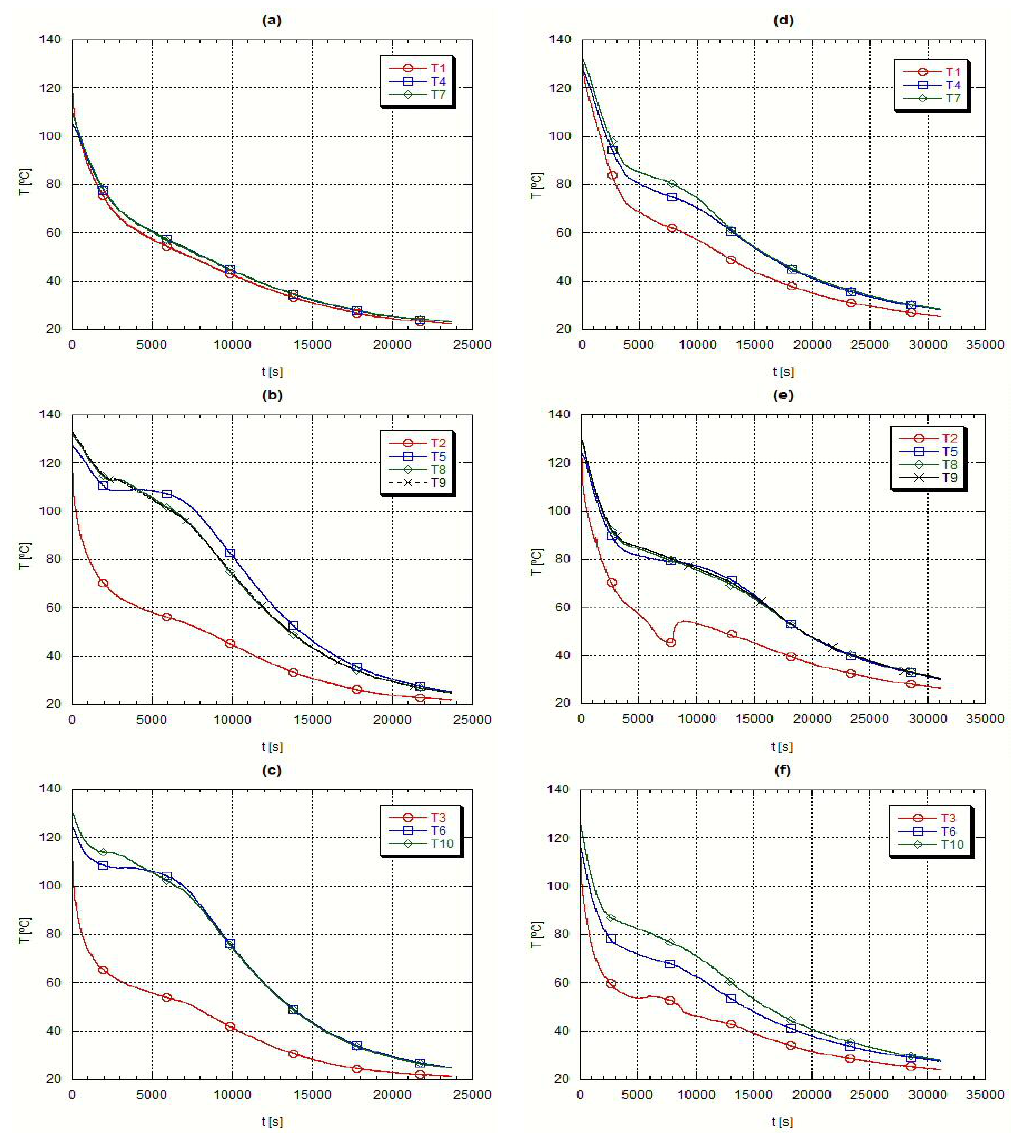
Figure 7. Radial evolution of phase change materials temperature during solidification. Plots ( a – c )—H105; Plots ( d – f )—A82.